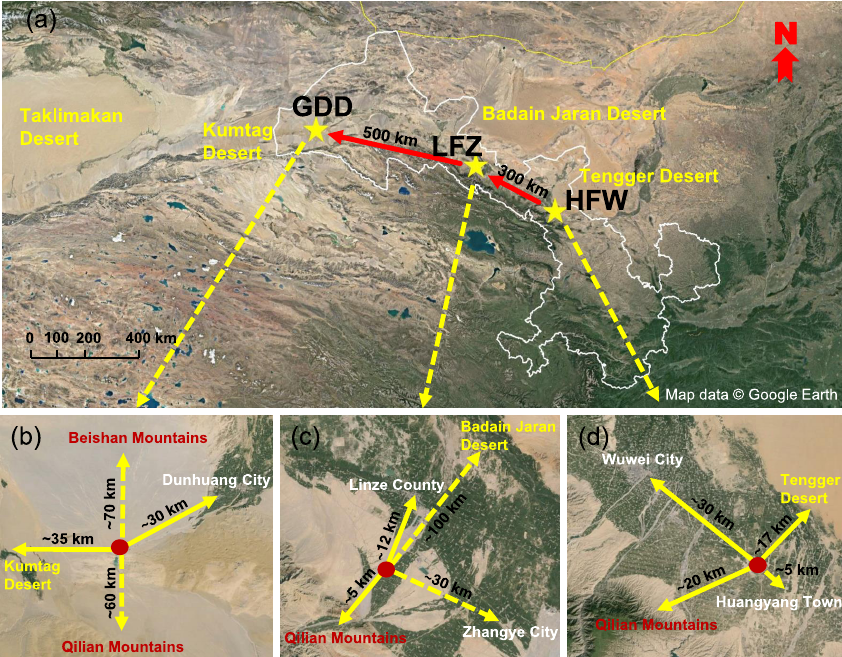
Figure 1. (a) The sampling locations of the ground-based mobile laboratory and their surrounding areas near dust source regions during the 2014 dust field campaigns at (b) the Gobi Desert in Dunhuang (GDD, 39.96 ◦ N, 94.33 ◦ E; 1367ma.s.l.), (c) Linze farmland in Zhangye (LFZ, 39.04 ◦ N, 100.12 ◦ E; 1578ma.s.l.), and (d) Huangyang farmland in Wuwei (HFW, 37.72 ◦ N, 102.89 ◦ E;